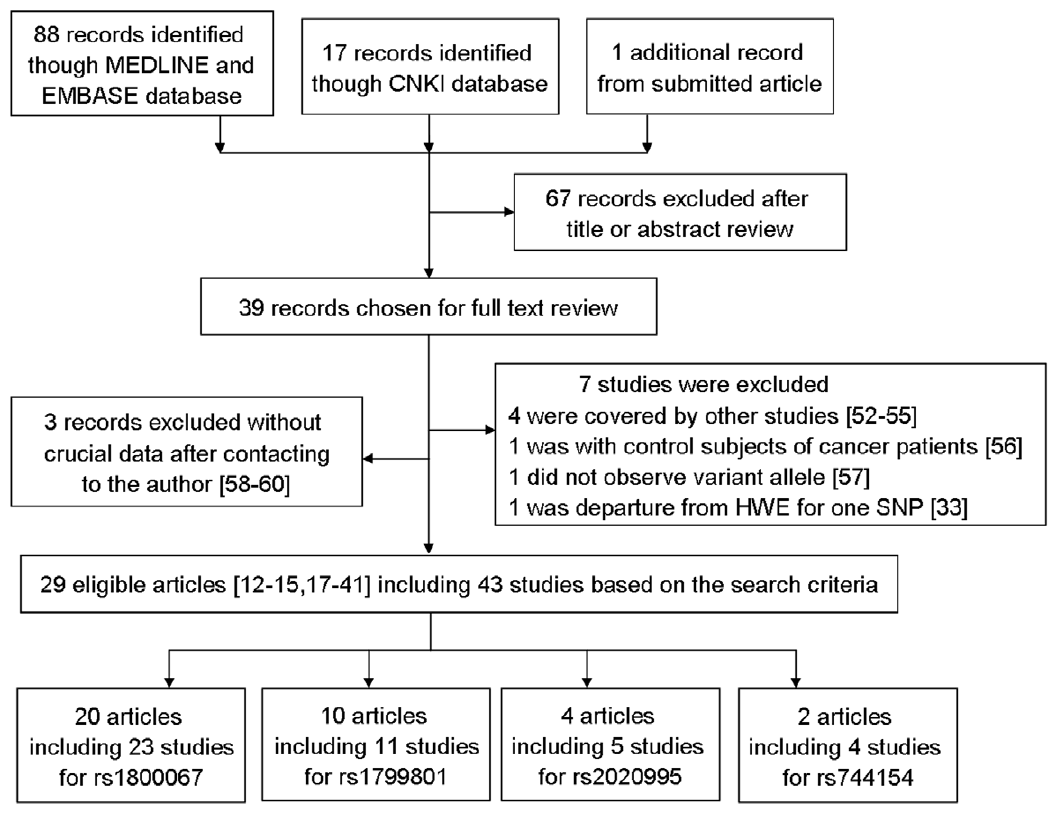
Figure 2. Flow diagram of included studies for this meta-analysis.